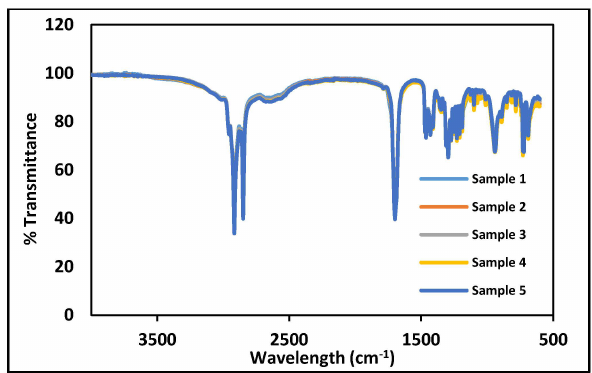
Figure 2. FTIR profile of 5 samples RWFO.